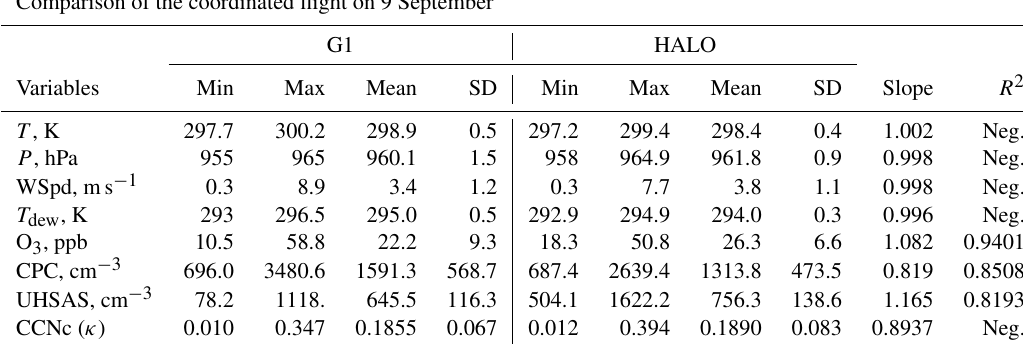
Table 3. Summary of basic statistics of data between in situ measurements on 9 September. Comparison of the coordinated flight on 9